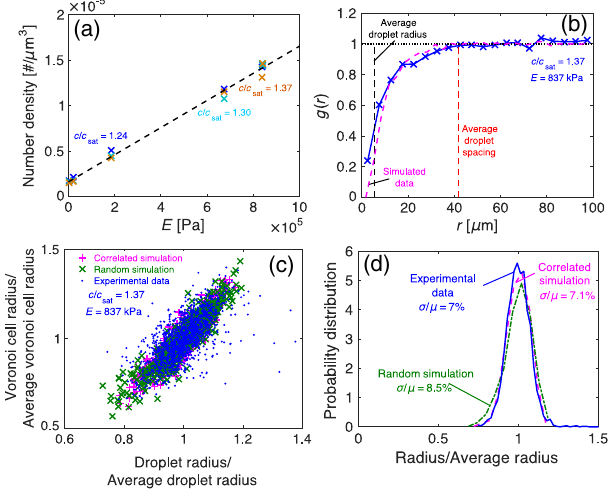
FIG. 5. Correlated nucleation and growth. (a) The number density of droplets depends on stiffness but not saturation. The dashed line is the line of best fit to the data. (b) The pair- correlation function g ð r Þ of droplet centers for a typical experi- ment (blue crosses) shows that nuclei do not form near each other. The range of internuclei repulsions is comparable to the inter- droplet distance. The pink line shows the g ð r Þ for nuclei positions in our Monte Carlo growth simulation. Note that the experimental measurements of g ð r Þ are only accurate for r ≳ 5 μ m because of the inaccuracy of out-of-plane tracking of droplet centers. (c) Droplet sizes are strongly correlated with the radius of their Voronoi cell. Blue: Data from the experiment in (b). Green and pink points show results of growth simulations with random and correlated nuclei positions. (d) Droplet size distributions for the experimental data in (b) (blue) and simulations with random (green) or correlated (pink)